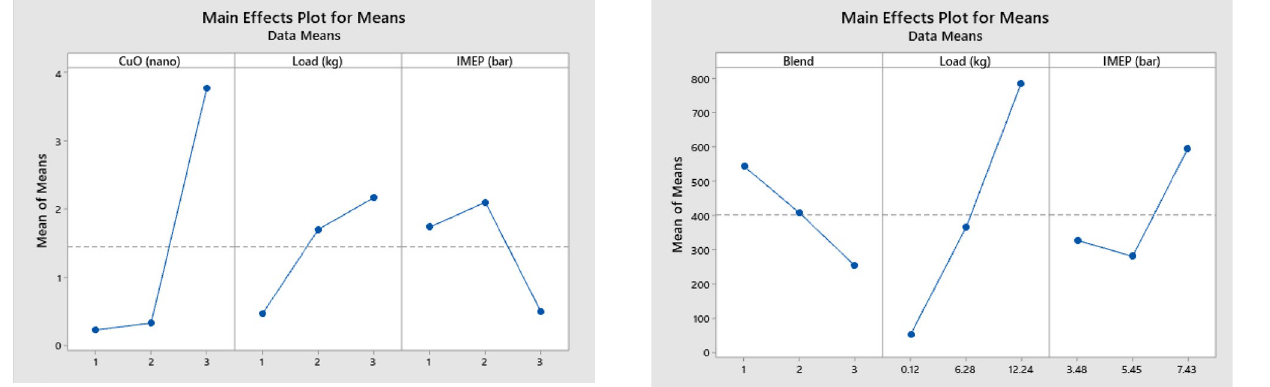
Fig. 10 Investigation by Taguchi: NOx versus blend, load (kg), IMEP (bar)